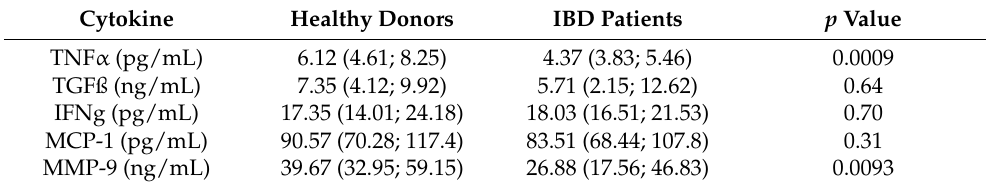
Table 2. Levels of cytokines in healthy donor and patient plasma. Cytokine levels in plasma of both healthy donors and IBD patients were measured by ELISA. Results obtained from analysis of plasma of n = 30 IBD patients and 30 matched healthy donors via Wilcoxon signed-rank test; p value considered significant when